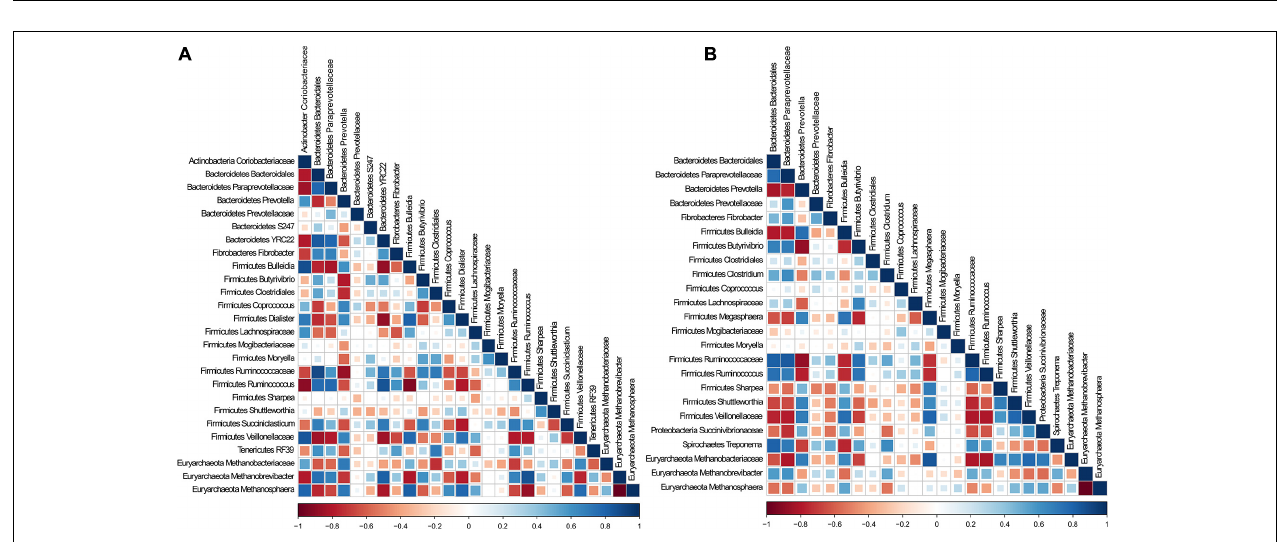
FIGURE 2 | Comparison of total (DNA-based) and potentially metabolically active (cDNA-based) bacterial (A,B) and archaeal (C,D) communities using principal coordinate analysis based on weighted UniFrac distances in CS (cannula solid; A,C) and TS (tube solid; B,D) samples.